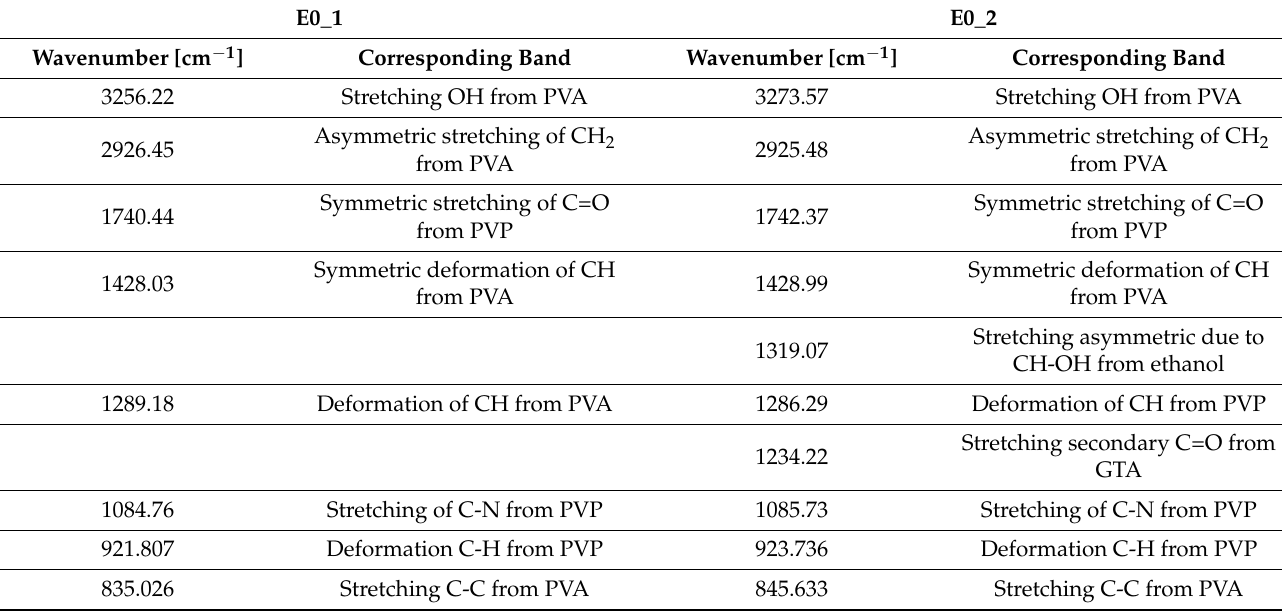
Table 6. Peaks assigned to specific vibrations of functional groups determined in the FTIR analysis of compositions E0_1 and E0_2.